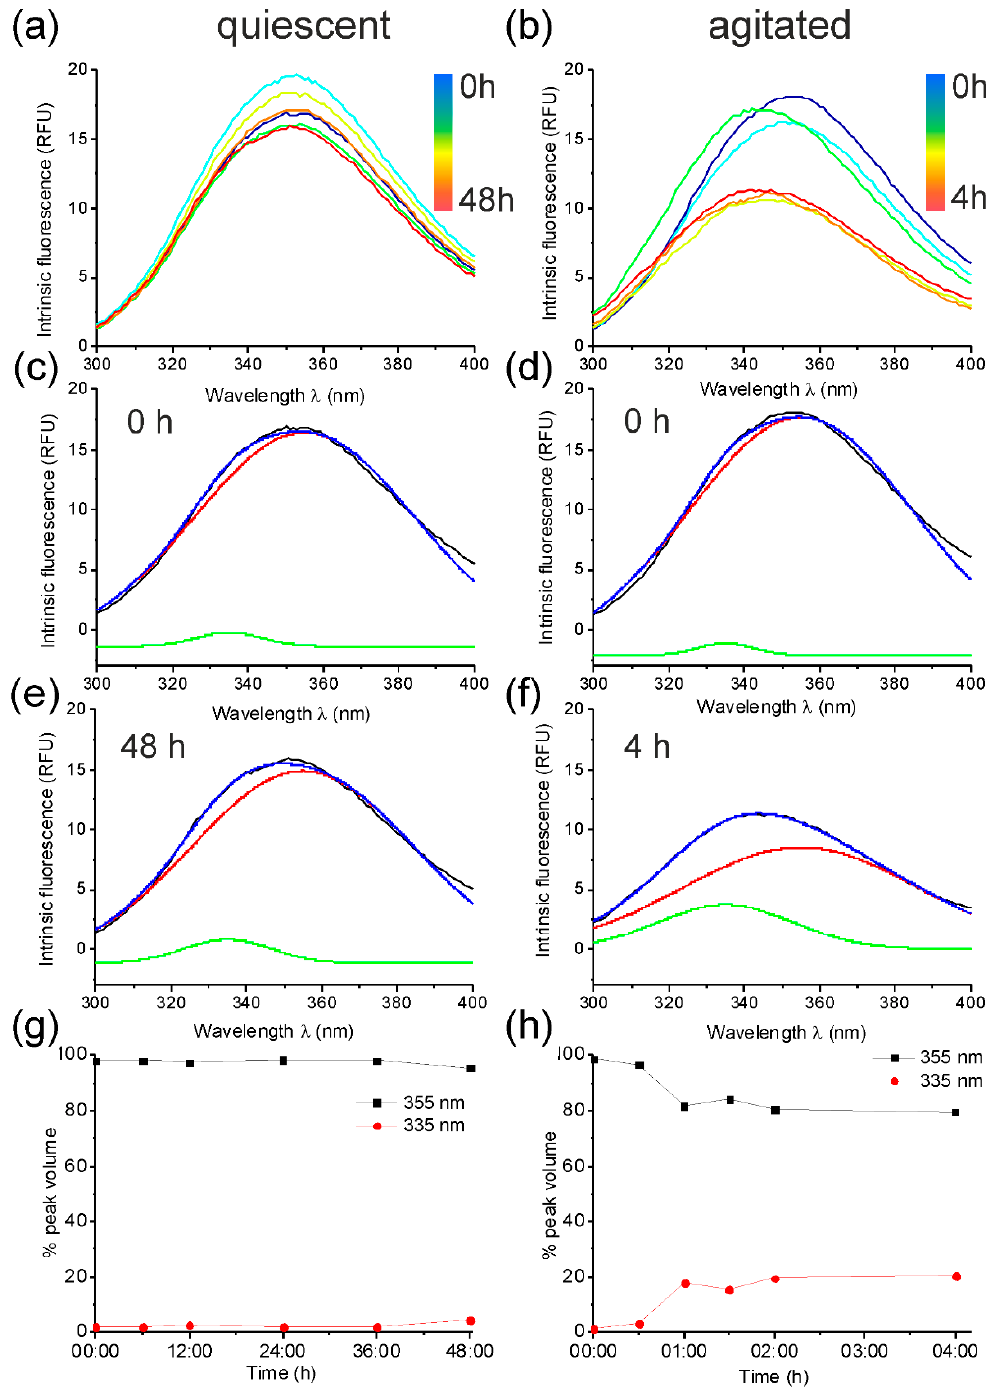
Figure 2. Intrinsic fluorescence of medin. Tryptophan fluorescence emission for 20 µM medin incubated in 20 mM NaPhos, 20 mM NaCl, pH 7.4 at 37 °C under quiescent (left) and agitated conditions (right). ( a , b ) Spectra were measured at intermediate timepoints during aggregation (0, 6, 12, 24, 36 and 48 h for quiescent and 0, 0.5, 1, 1.5, 2 and 4 h for agitated). Fluorescence spectra (black) for start (0 h, ( c , d )) and end (48 h, ( e ) and 4 h, ( f )) were deconvoluted with nonlinear least-squares fitted spectra (blue) approximated by two Gaussian components centred at 355 nm (red) and 335 nm (green) (see Methods for full details). ( g , h ) The areas of the Gaussian curve fits (centred at 355 and 335 nm as shown in ( c,d,e , f )) were used to calculate the fraction of each contributing to the overall spectra at each timepoint.